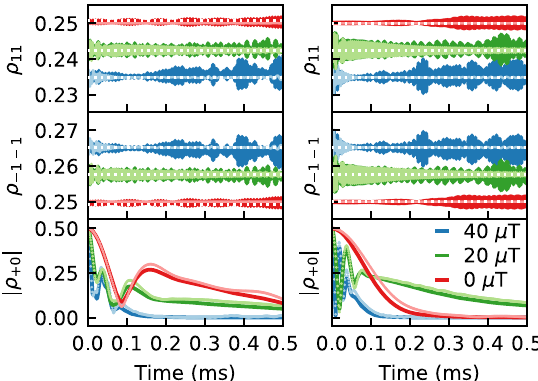
FIG. 14. The distribution of coherence times T ∗ (bottom) for theoretical nuclear configurations obtained for VVA (red) and VVB (orange). Blue lines correspond to configurations shown in the main